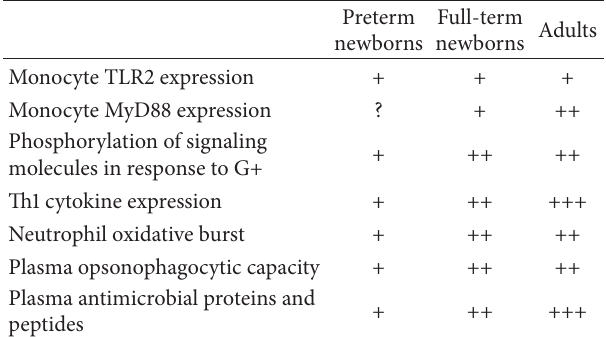
Preterm Full-term Adults newborns newborns